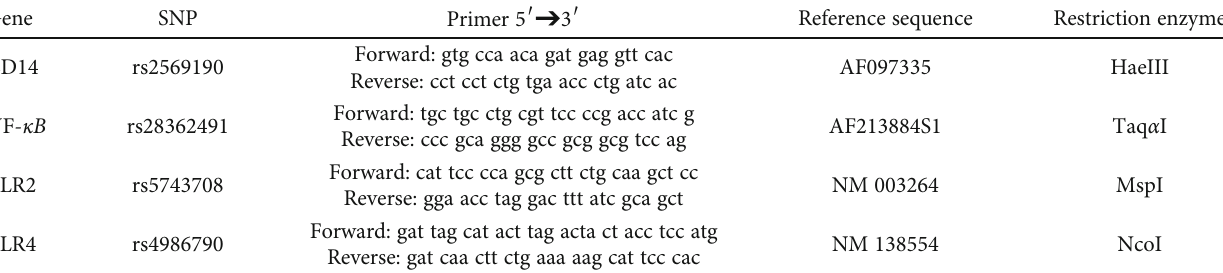
Table 1: Genotyping methods applied for SNPs in CD14, NF- κ Β , TLR2, and